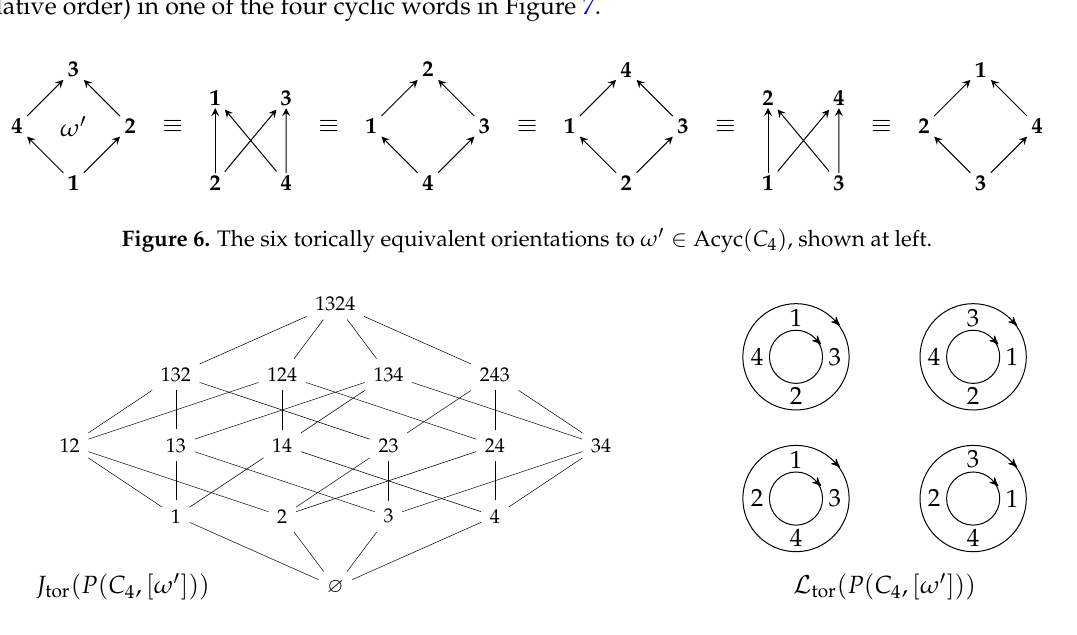
Figure 7. The toric filters of the toric poset P ( C 4 , [ ω (cid:48) ]) form a poset that happens to be a lattice. Each toric filter appears as a consecutive sequence in one of the total toric extensions, shown at